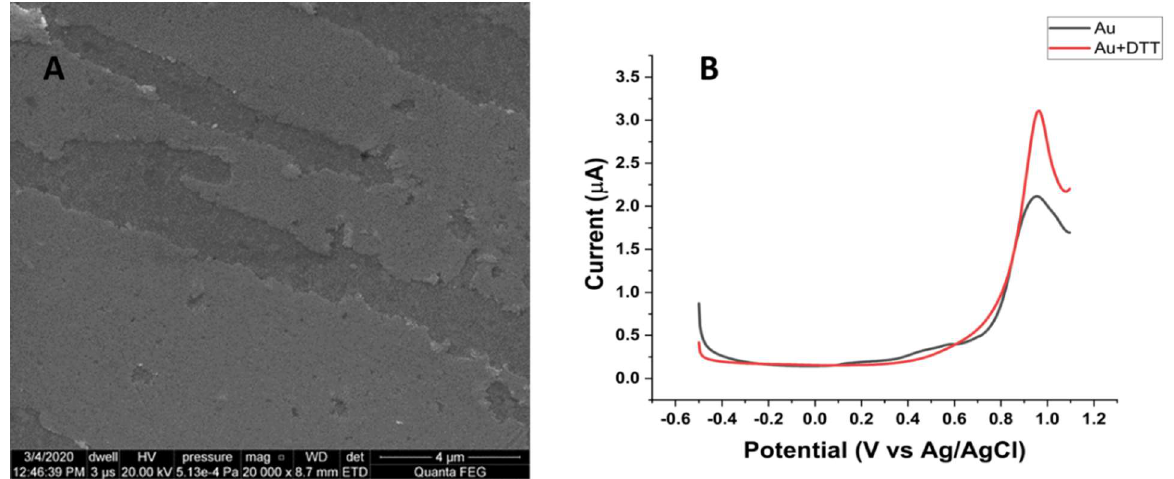
Figure 2. ( A ) SEM micrograph of the bare electrode illustrates the surface is least heterogeneous with an average surface roughness of 0.03 µ m. ( B ) DPV of the bare gold electrode in 0.1 M phosphate buffer, pH 7.0 (black curve) with DTT adsorbed on the gold surface (red curve).